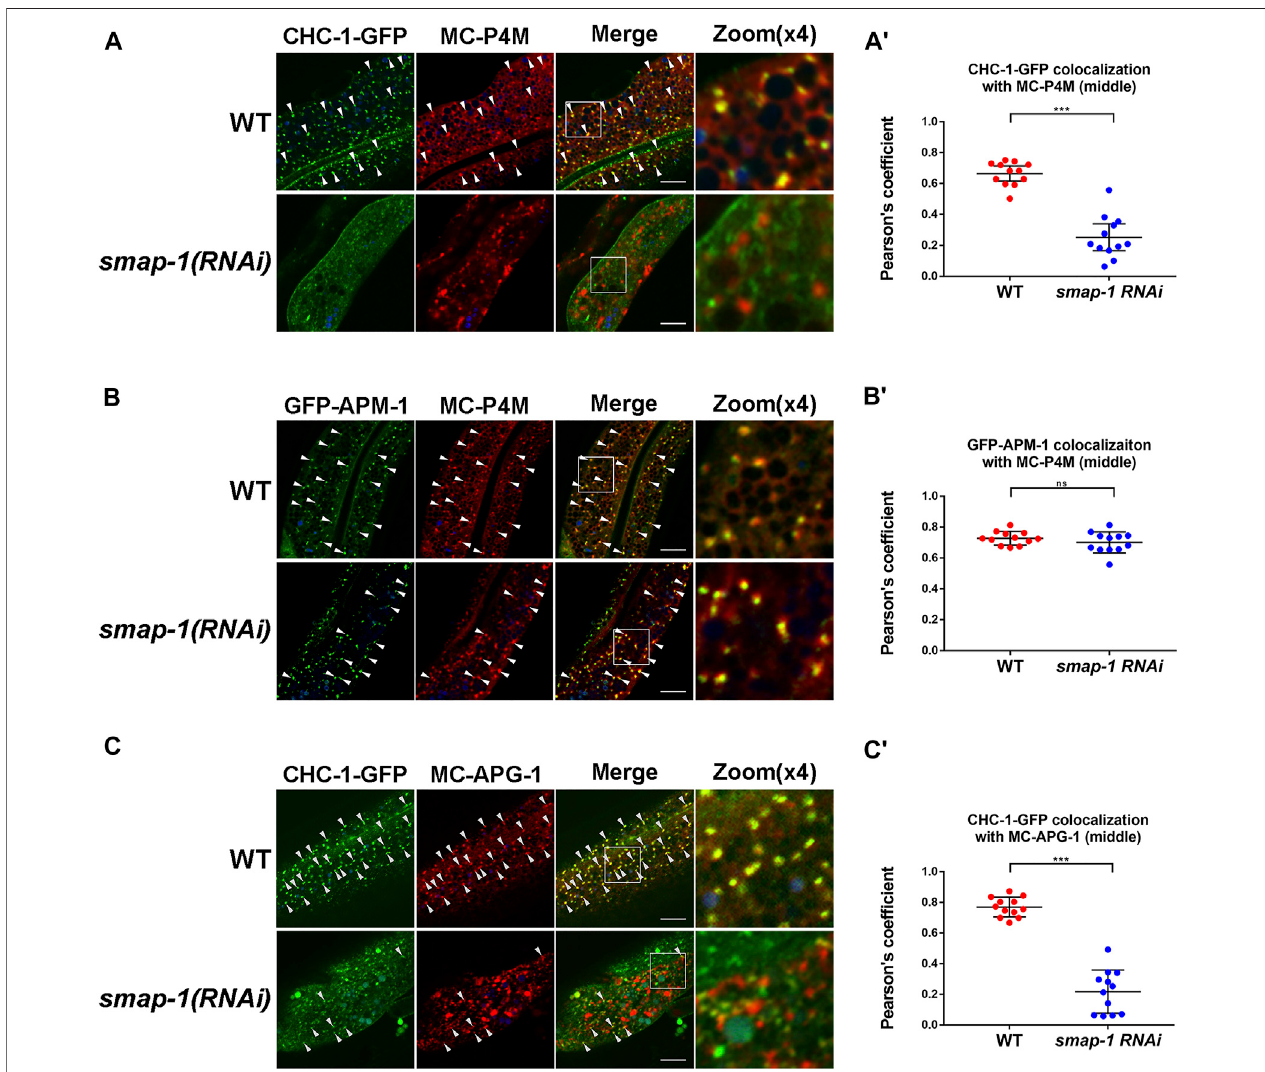
FIGURE5| LossofSMAP-1leadstoadecreaseinTGN-locatedclathrin. (A-A 9 ) LossofSMAP-1ledtoadecreaseinthecolocalizationbetweenCHC-1andP4M. Pearson ’ s correlation coef fi cients are calculated, error bars are 95% CIs (n (cid:1) 12 animals). p -value: Mann-Whitney test. *** p < 0.001. (B-B 9 ) The colocalization between APM-1andP4MwasnotaffectedbythedepletionofSMAP-1.Pearson ’ scorrelation coef fi cientsarecalculated,errorbarsare95%CIs(n (cid:1) 12animals). p -value:Mann- Whitney test. ns: no signi fi cance. (C-C 9 ) In the absence of SMAP-1, CHC-1 failed to overlap with APG-1 in punctate structures. Pearson ’ s correlation coef fi cients are calculated, error bars are 95% CIs (n (cid:1) 12 animals). p -value: Mann-Whitney test. *** p < 0.001. Scale bars, 10 μ m.